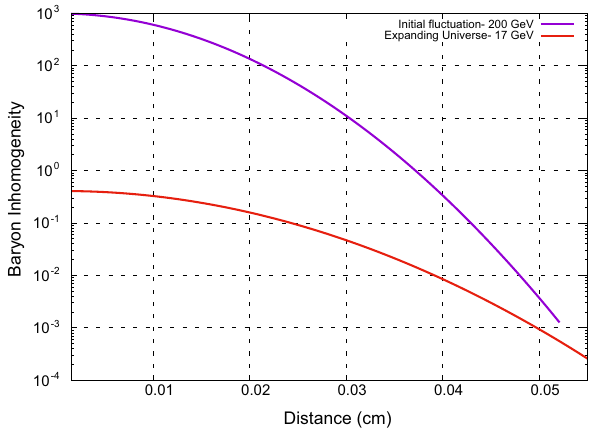
Fig. 1 The initial fluctuation at 200 GeV in the linear scale